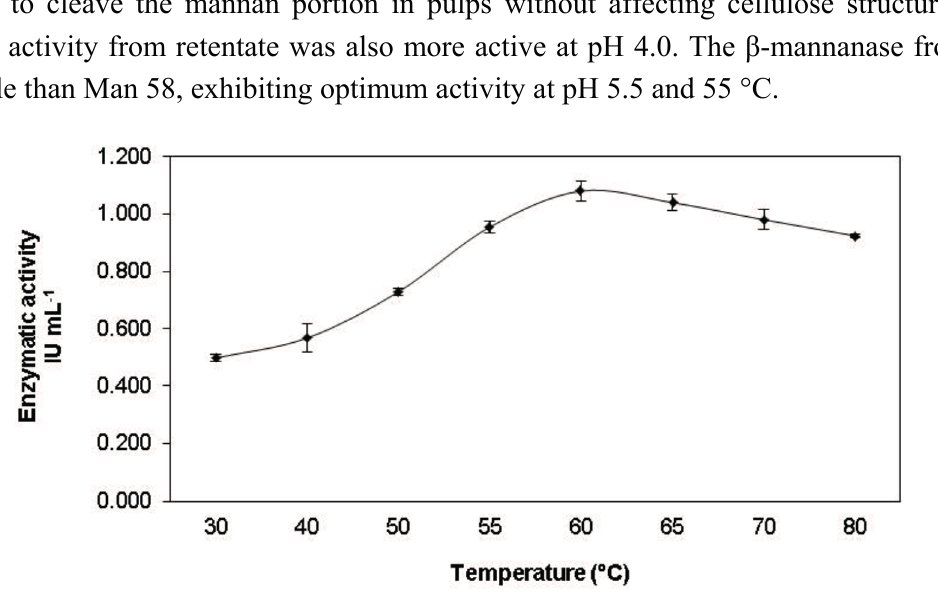
Figure 4. Effect of temperature on Man 58